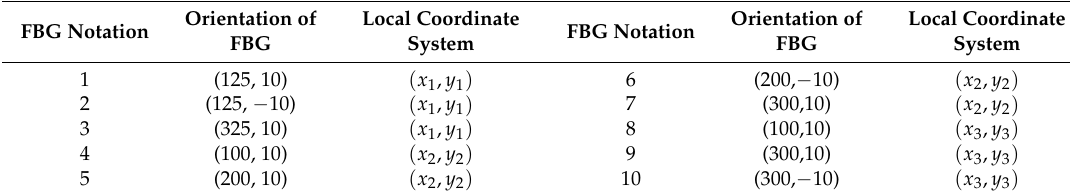
Table 1. The locations of FBG (Unit: mm).